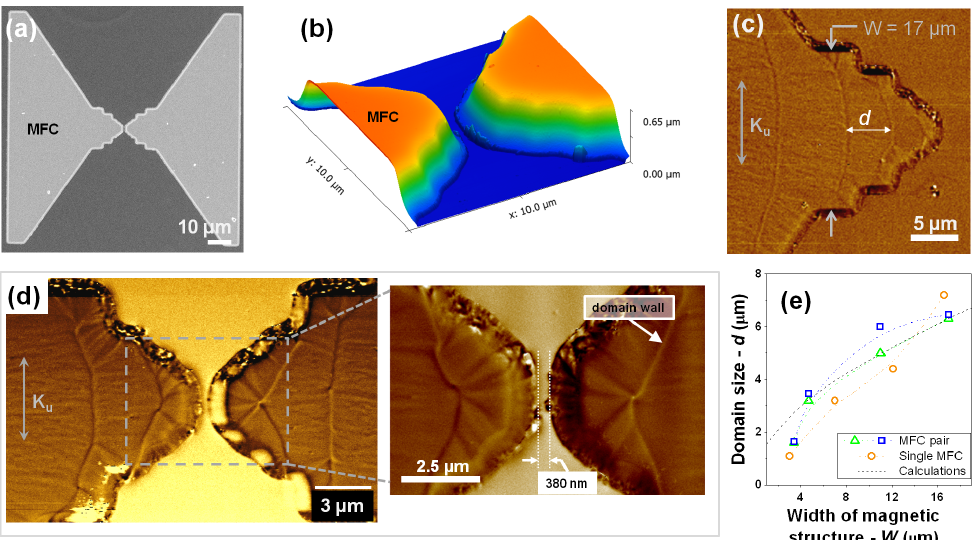
Figure 3. ( a ) SEM top view of a pair of patterned MFCs elements (6000Å-thick CZN) and ( b ) corresponding atomic force microscopy (AFM) topography view centered at the gap region, highlighting the clean liftoff profile without residues. Magnetic Force Microscopy (MFM) images of the poles domain structure at remanence in a ( c ) single and ( d ) pair of patterned MFCs. Inset: detail for the domain configuration of the smallest gap defines without SV sensor; ( e ) Comparison between calculated and measured domain